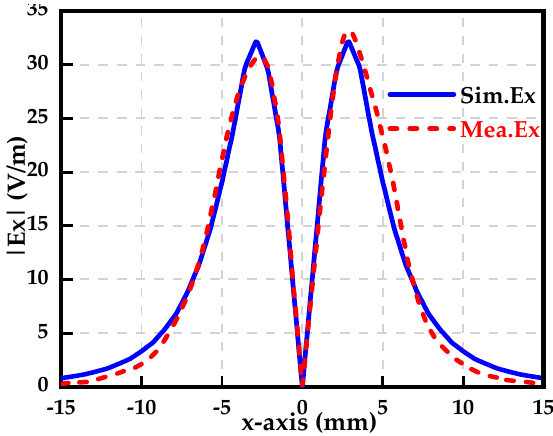
Figure 17. Simulated and measured Ex at the height of 2 mm above the microstrip line.